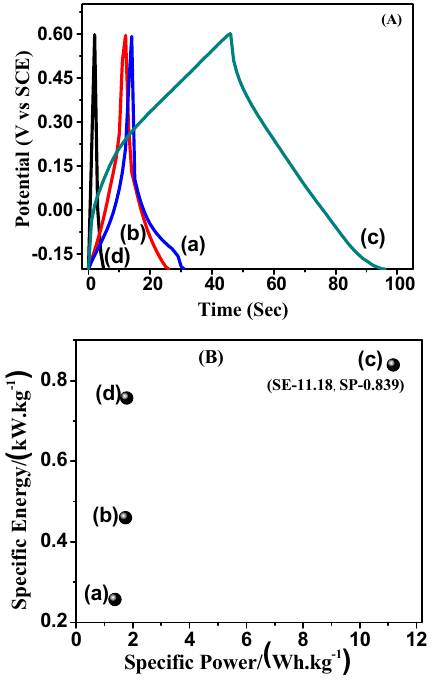
Fig. 4 The SEM images of SnO 2 -RuO 2 mixed films for samples (a) S1 (SnO 2 :RuO 2 , 3:2), (b) S2 (1:1), (c) S3 (1:3) and (d) S4 (2:3) at 10, 000X magnification, e) EDAX spectra for (i) S1 (SnO 2 :RuO 2 ,